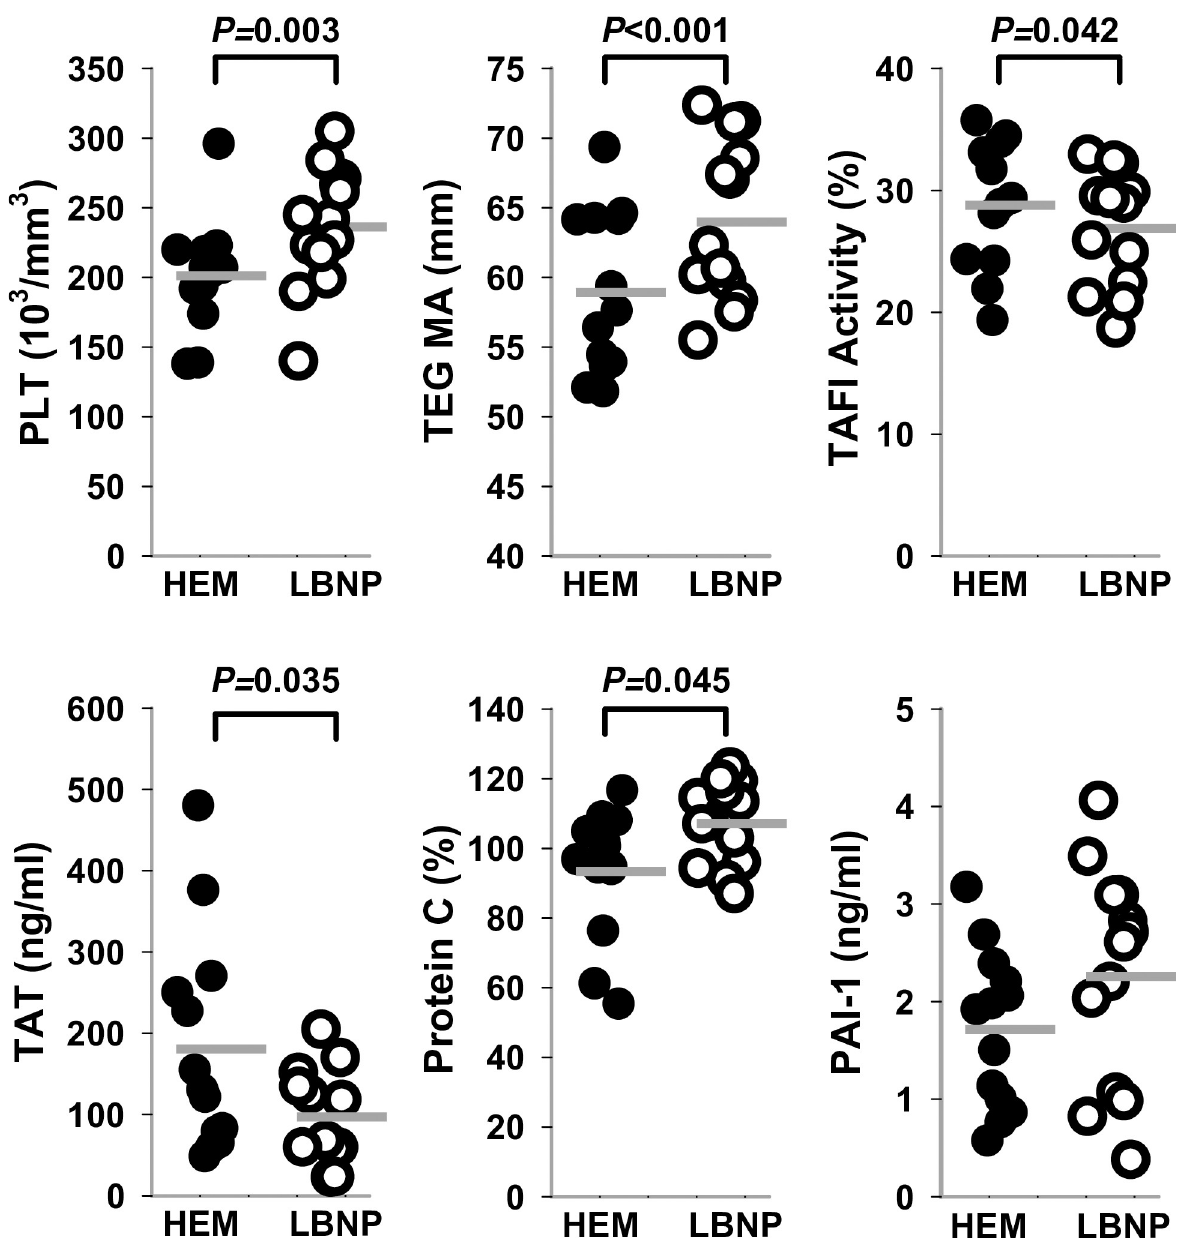
Fig 1. Swarm plot of selected data with baseline (BL) values for blood removal (HEM) and lower body negative pressure (LBNP) trials. LBNP BL values were obtained 4 weeks after HEM BL. P -values of significantly different parameters between trials as determined by one-way RMANOVA are shown above graph. Mean is presented as a gray